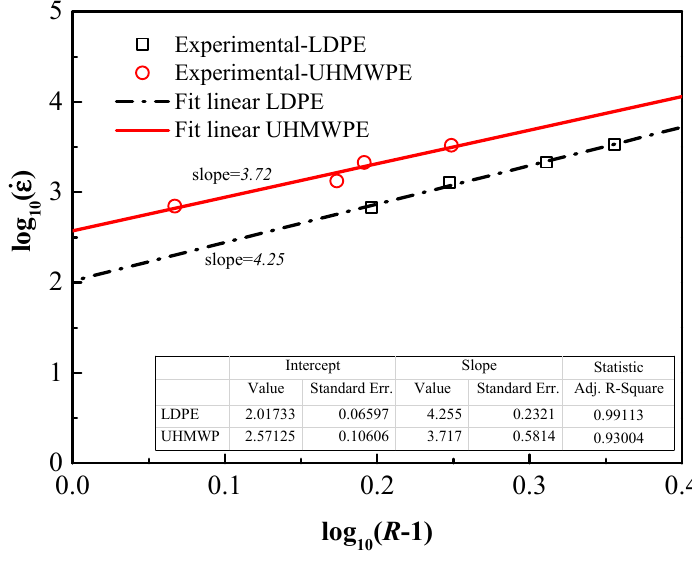
Table 5. Coefficients for Cowper–Symonds model.